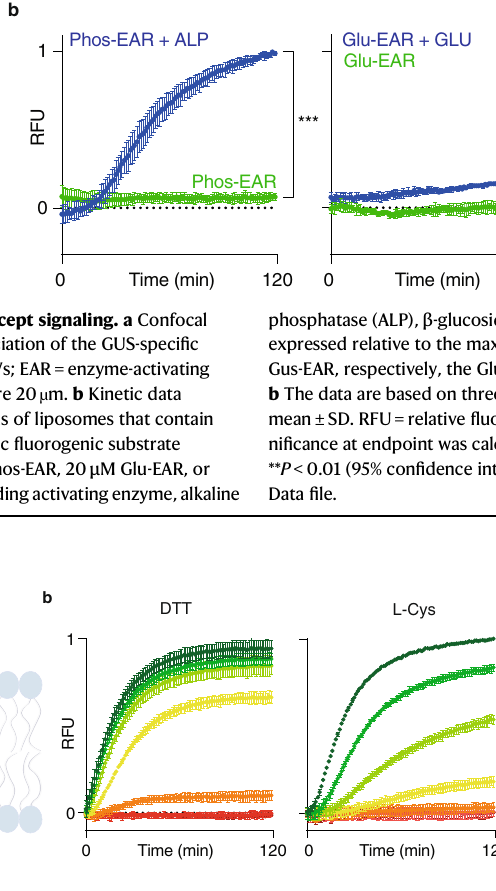
and triggered by the addition of ALP ( c ). b , c Results shown are based on three replicates with triplicates ( N =3, n =3) presented as mean±SD.; RFU=relative fl uorescence expressed in arbitrary units. c Statistical signi fi cance at endpoint was calculated via an unpaired two-tailed t test, *** P <0.001 (95% con fi dence interval). Source data are provided as the Source Data fi le.